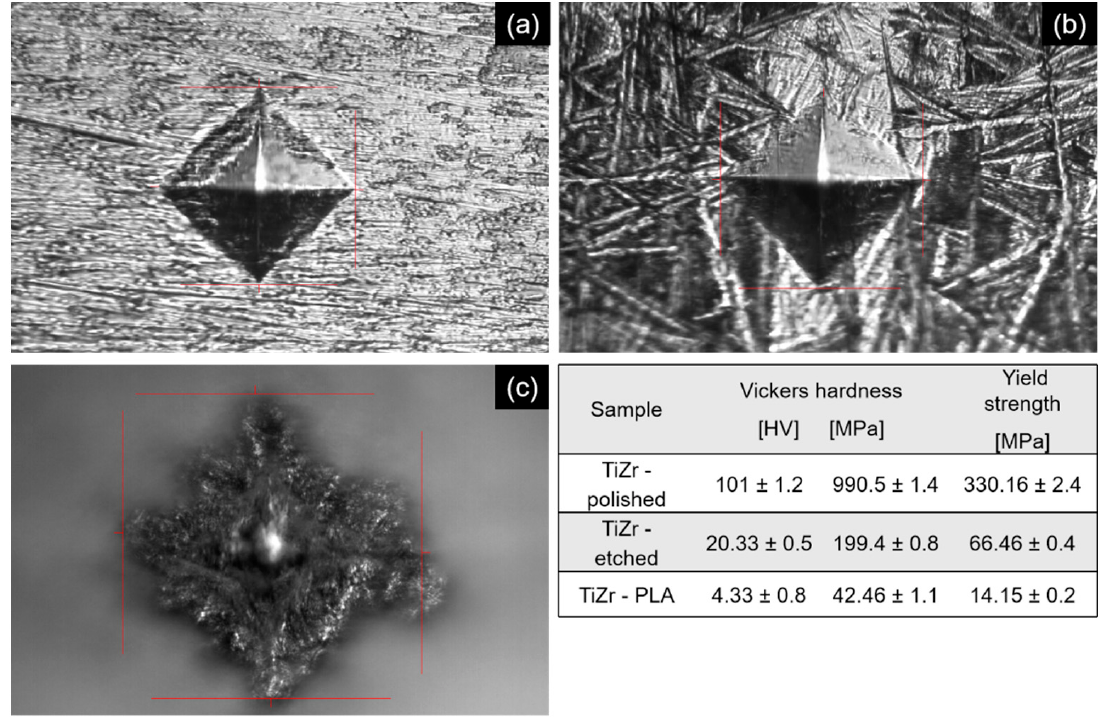
Figure 3. Morphology of samples after microhardness tests: ( a ) polished TiZr; ( b ) etched TiZr; ( c ) etched TiZr covered with PLA nanofibers and calculated forces.